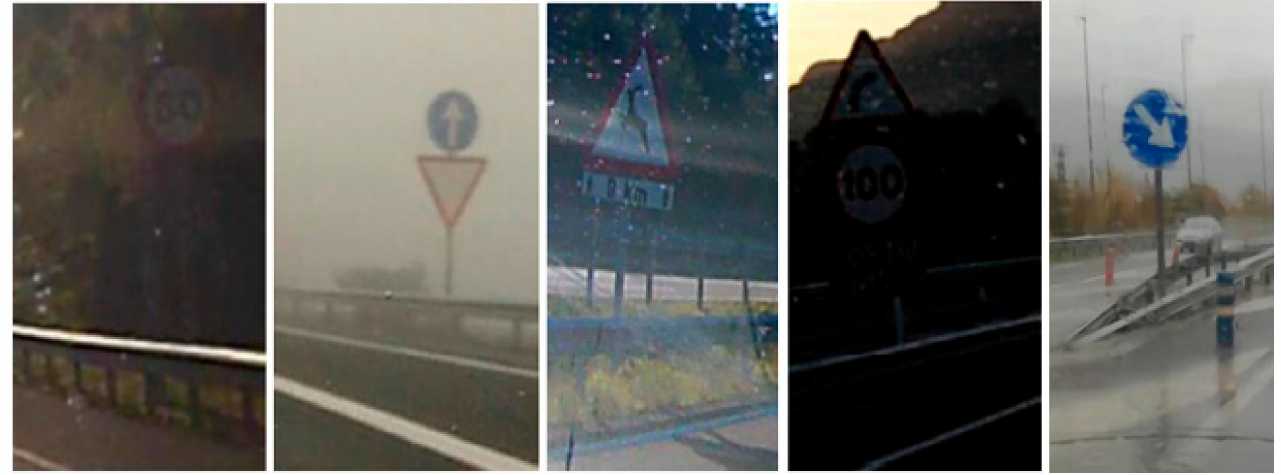
Figure 1. Ceit-TSR database. Sample images showing some of the challenging conditions: low contrast, fog, reflections, shadows and heavy